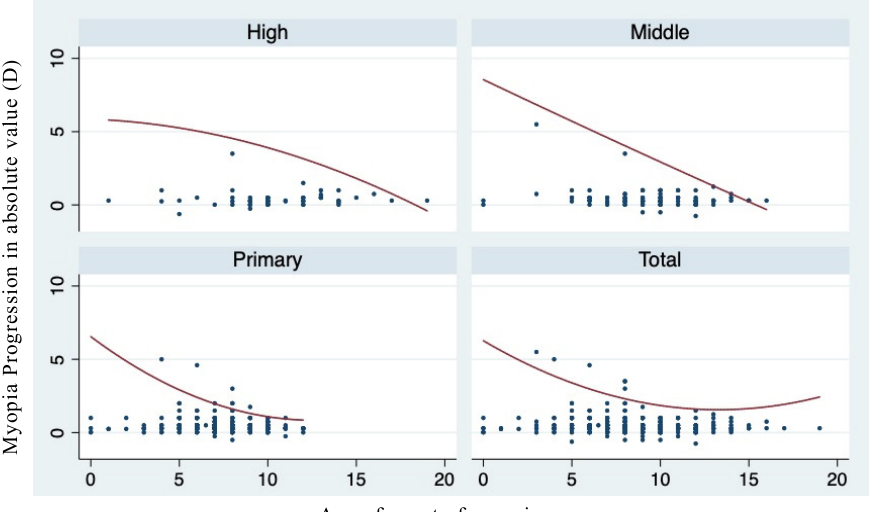
Figure 1. Age of onset of myopia and current myopia severity of the schoolchildren.